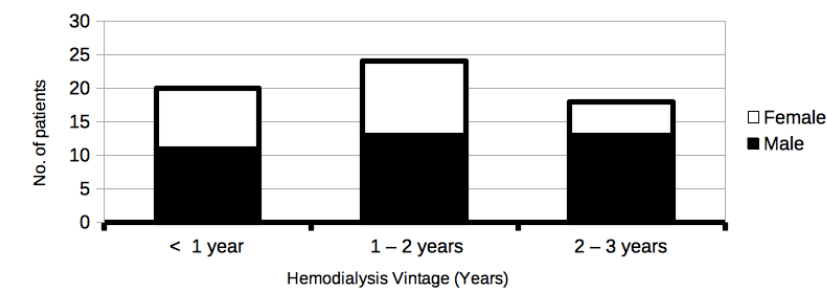
Figure2: Hemodialysis vintage of the